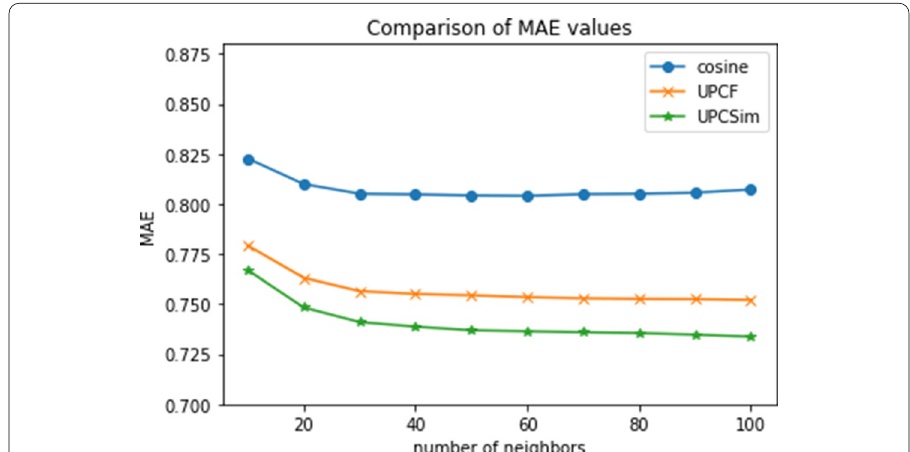
Fig. 3 Comparison of the average MAE values of the three similarity algorithms using MovieLens 100K